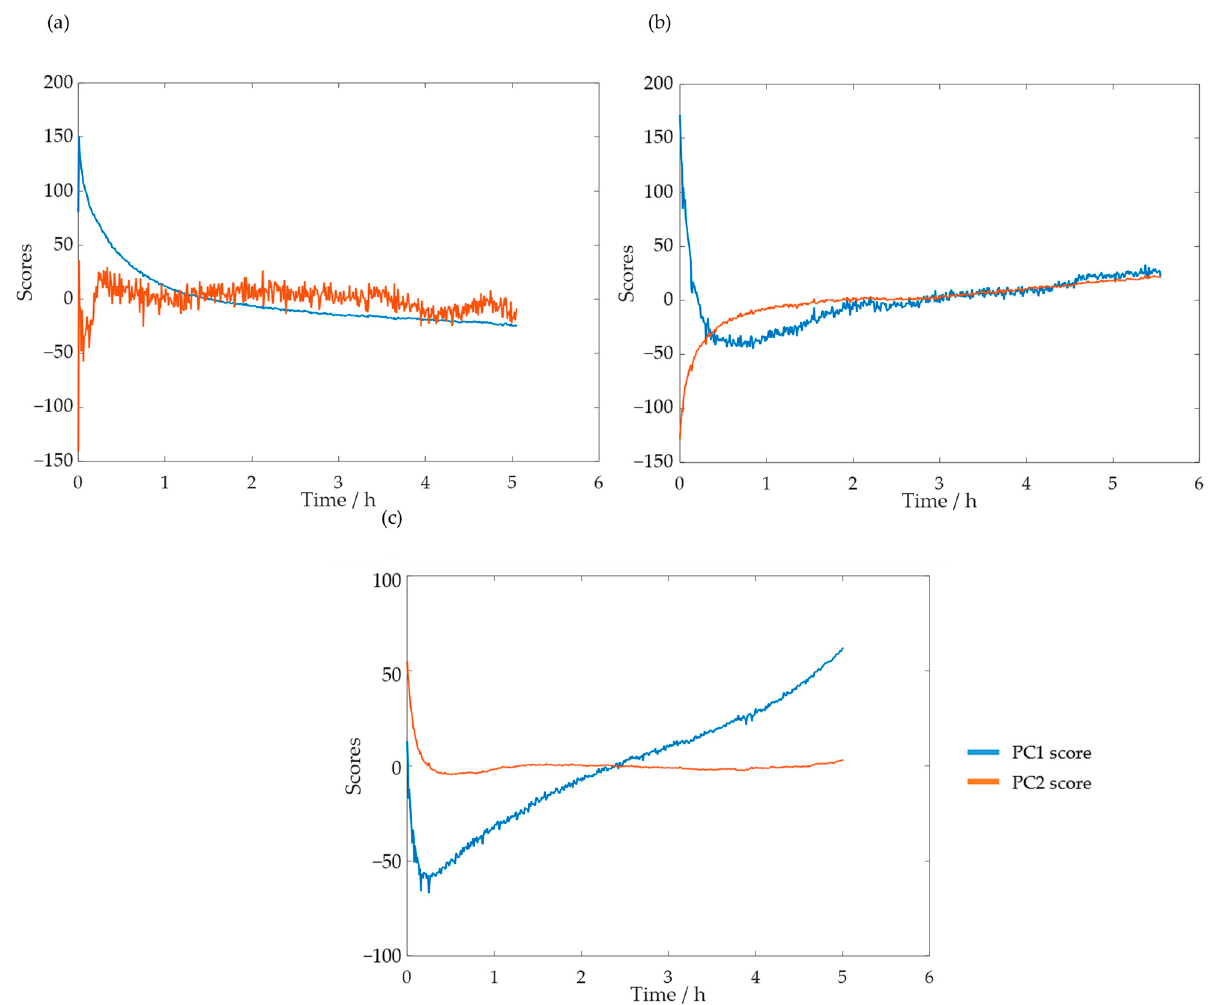
Figure 13. PC1 and PC2 scores for the methylolation of the HLS sample at 50 °C ( a ), 60 °C ( b ), and 70 °C ( c ).